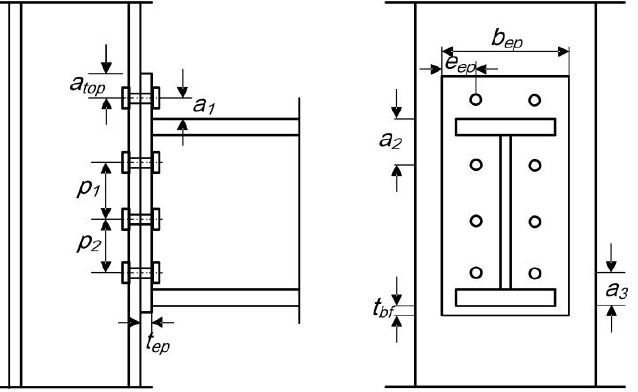
Figure 16. The layout of the extended end-plate connection.